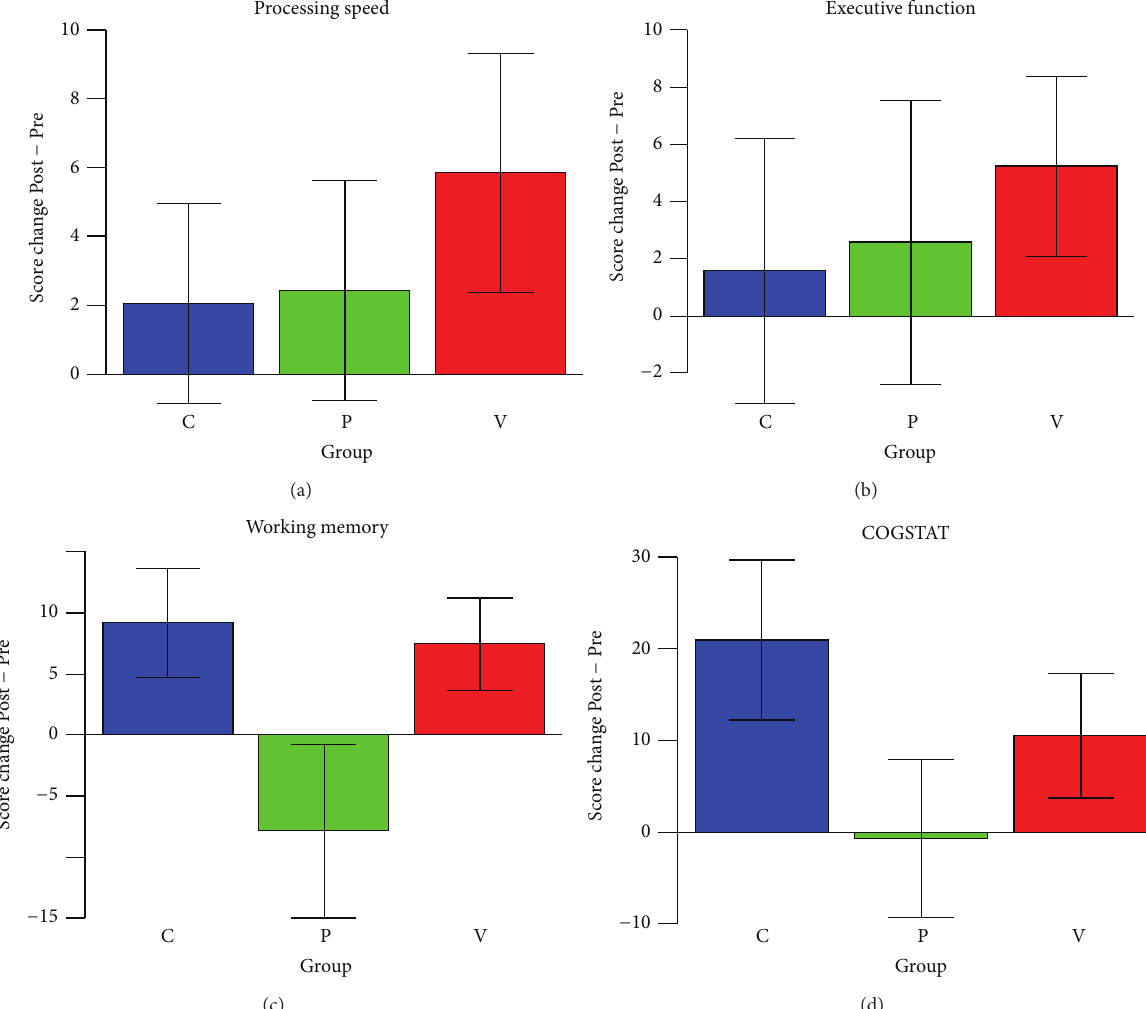
Figure 2: Changes in the cognitive function composite scores in each training group. (a) Processing speed was evaluated as a composite of the Trail Making Test- (TMT-) A and Symbol-Digit Modalities Test (SDMT) measures. (b) Executive function was evaluated as a composite of the Frontal Assessment Battery (FAB), Word Fluency Test (WFT), and TMT-B test measures. (c) Working memory was evaluated as a composite of the Spatial Span (SS), Benton Visual Retention Test (BVRT), and Auditory-Verbal Learning Test (AVLT) measures. (d) Composite measure of cognitive impairment (COGSTAT) [5] was evaluated by combining the Block Design (BD), WFT, TMT-B, BVRT, Complex Figure Test- (CFT-) Copy, CFT-Recall, AVLT, and Judgment of Line Orientation (JLO) scores. Score changes were adjusted for age, sex, and Pre (baseline) scores. The error bars in the graphs show the standard errors of the mean (SEM) for the subjects in each